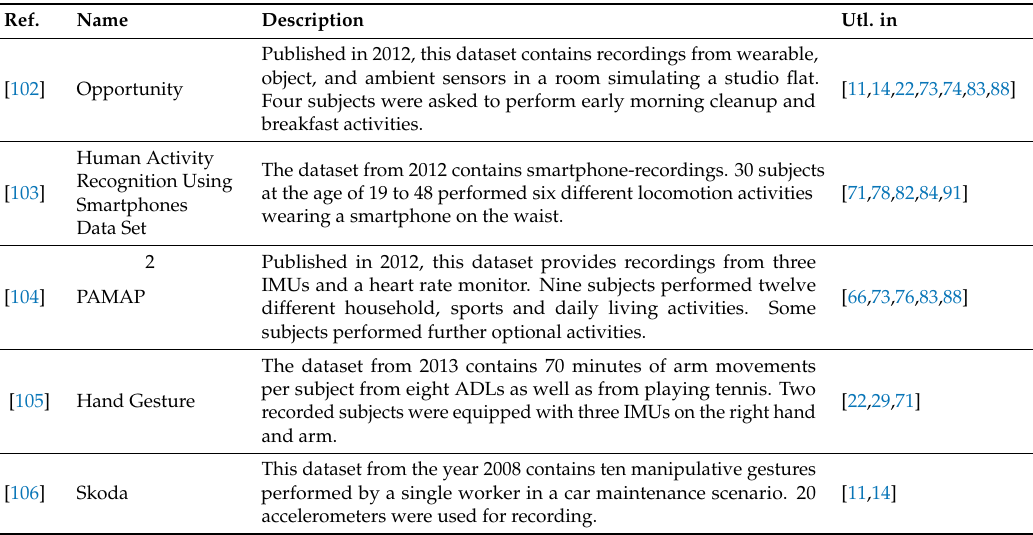
Table 9. Overview of publicly available datasets utilised by two or more relevant contributions.